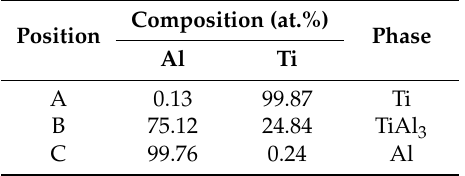
Figure 2. SEM images of the interfacial zone of samples annealed and EDX results; ( a ) annealing time 5 h, ( b ) annealing time 32 h, ( c ) annealing time 96 h, ( d ) EDX results.